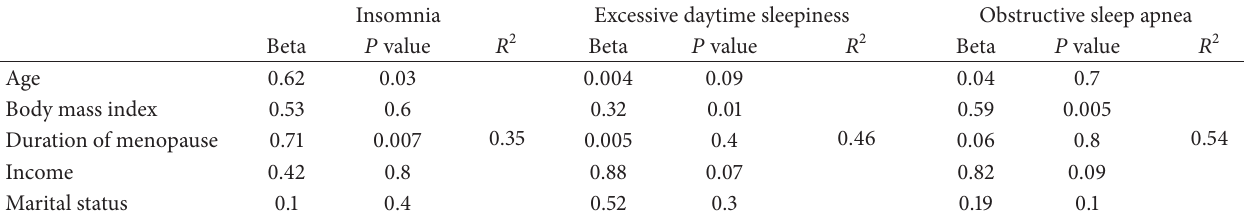
Table 2: Multiple regression analysis between demographic and clinical characteristics and EDS, insomnia, and OSA.